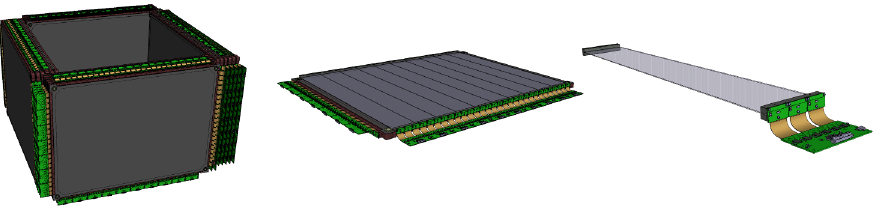
Figure 5. Sketch of the 4-side FIT detector (left). Sketch of one x-y plane (center). Sketch of a FIT module